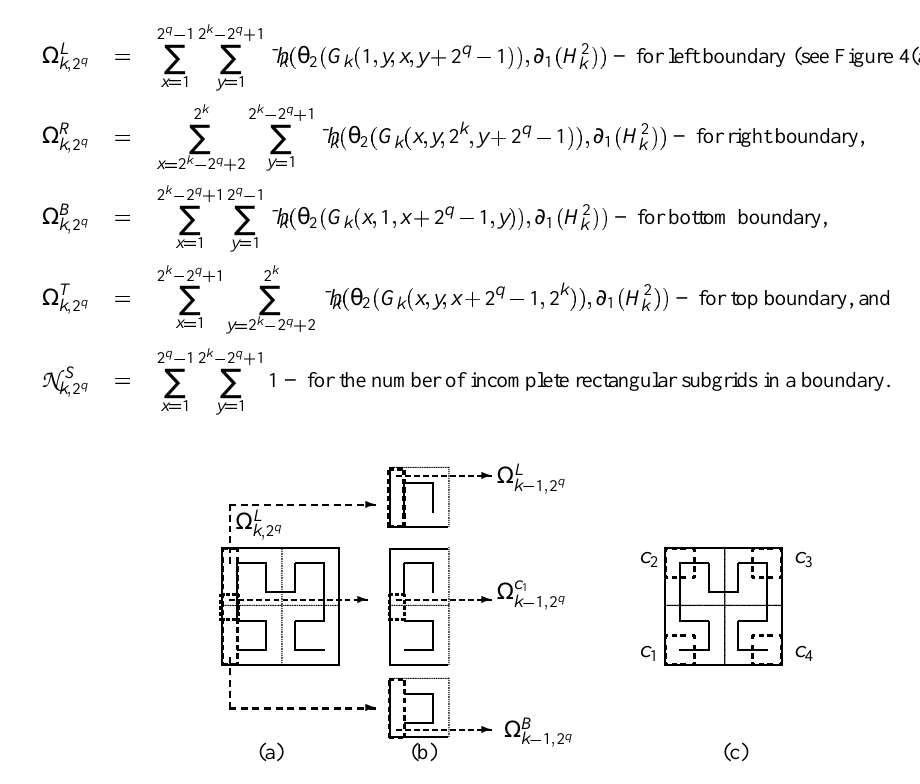
Fig. 4: (a) W L canonical H 2